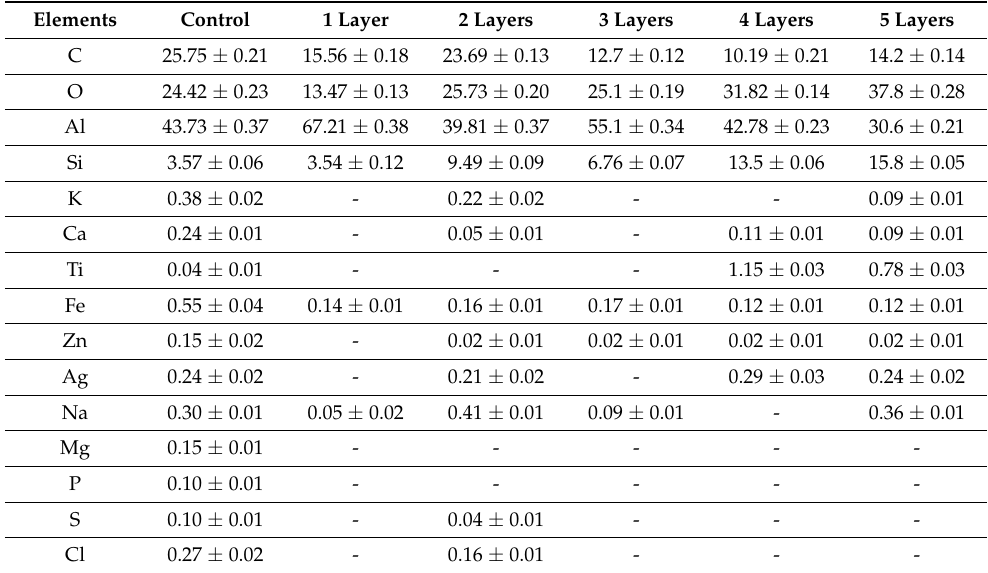
Table 4. The ratio of elements (% atom.) present in the samples prepared with the method of immersion of samples in SiO 2 nanoparticles